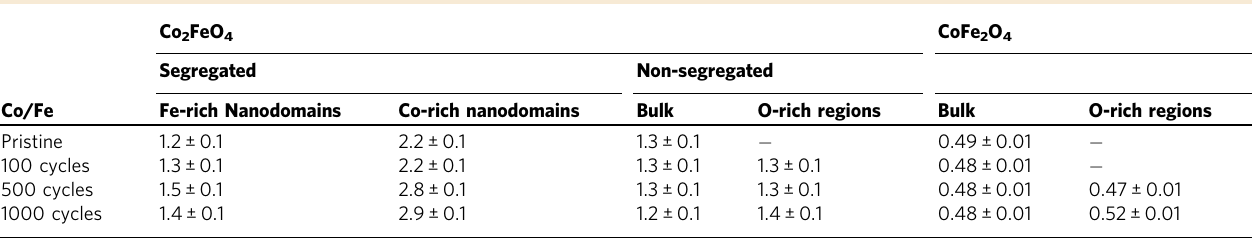
The error bars for the ratio were calculated from R (Source data is provided in a Source Data fi le).